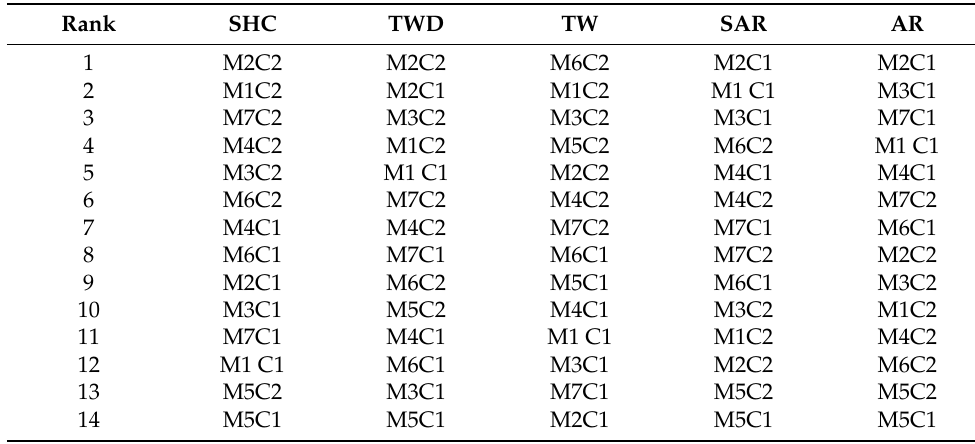
Table 6. Overall ranking of ML models under different climatic zones.